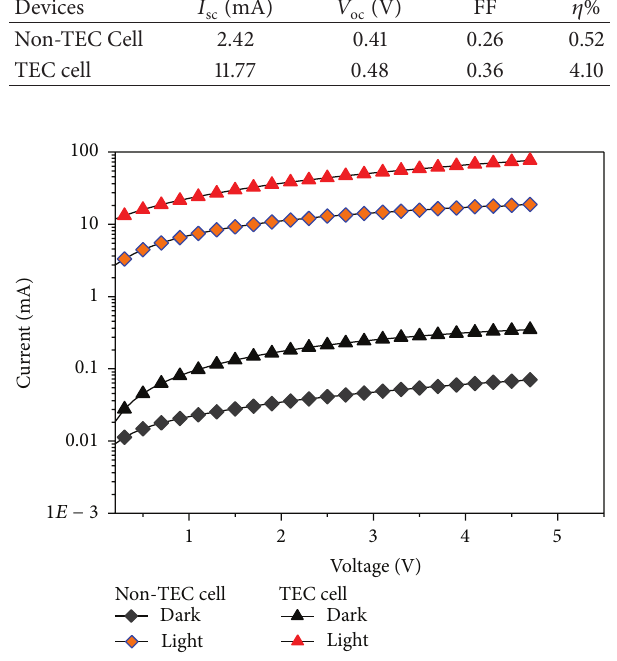
Figure 5: Photocurrent and dark current of the NPS/poly-Si cells with and without a trenched-electrode-contact (TEC) structure. The photocurrent is measured by a solar simulator under 𝑃 𝐿 = 100 mA/cm 2 at AM1.5.